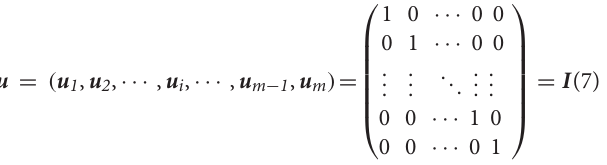
second output matrix, the feedthrough matrix D ∈ R pxm , may